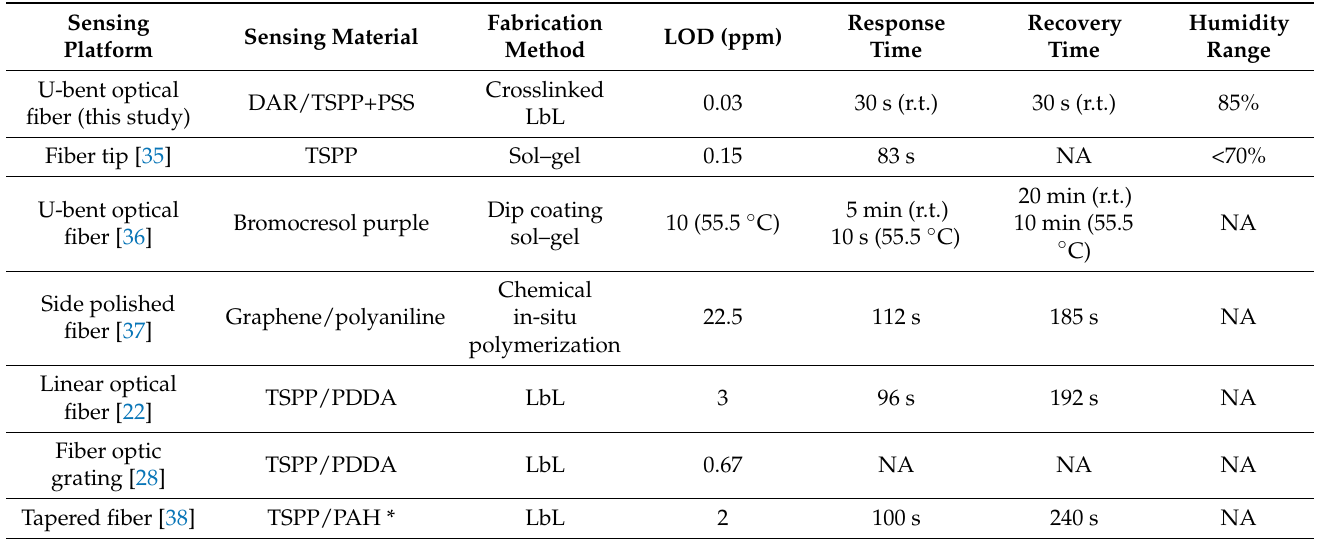
Table 3. A summary based on the comparison of the proposed ammonia sensor to the previously published OFSs.